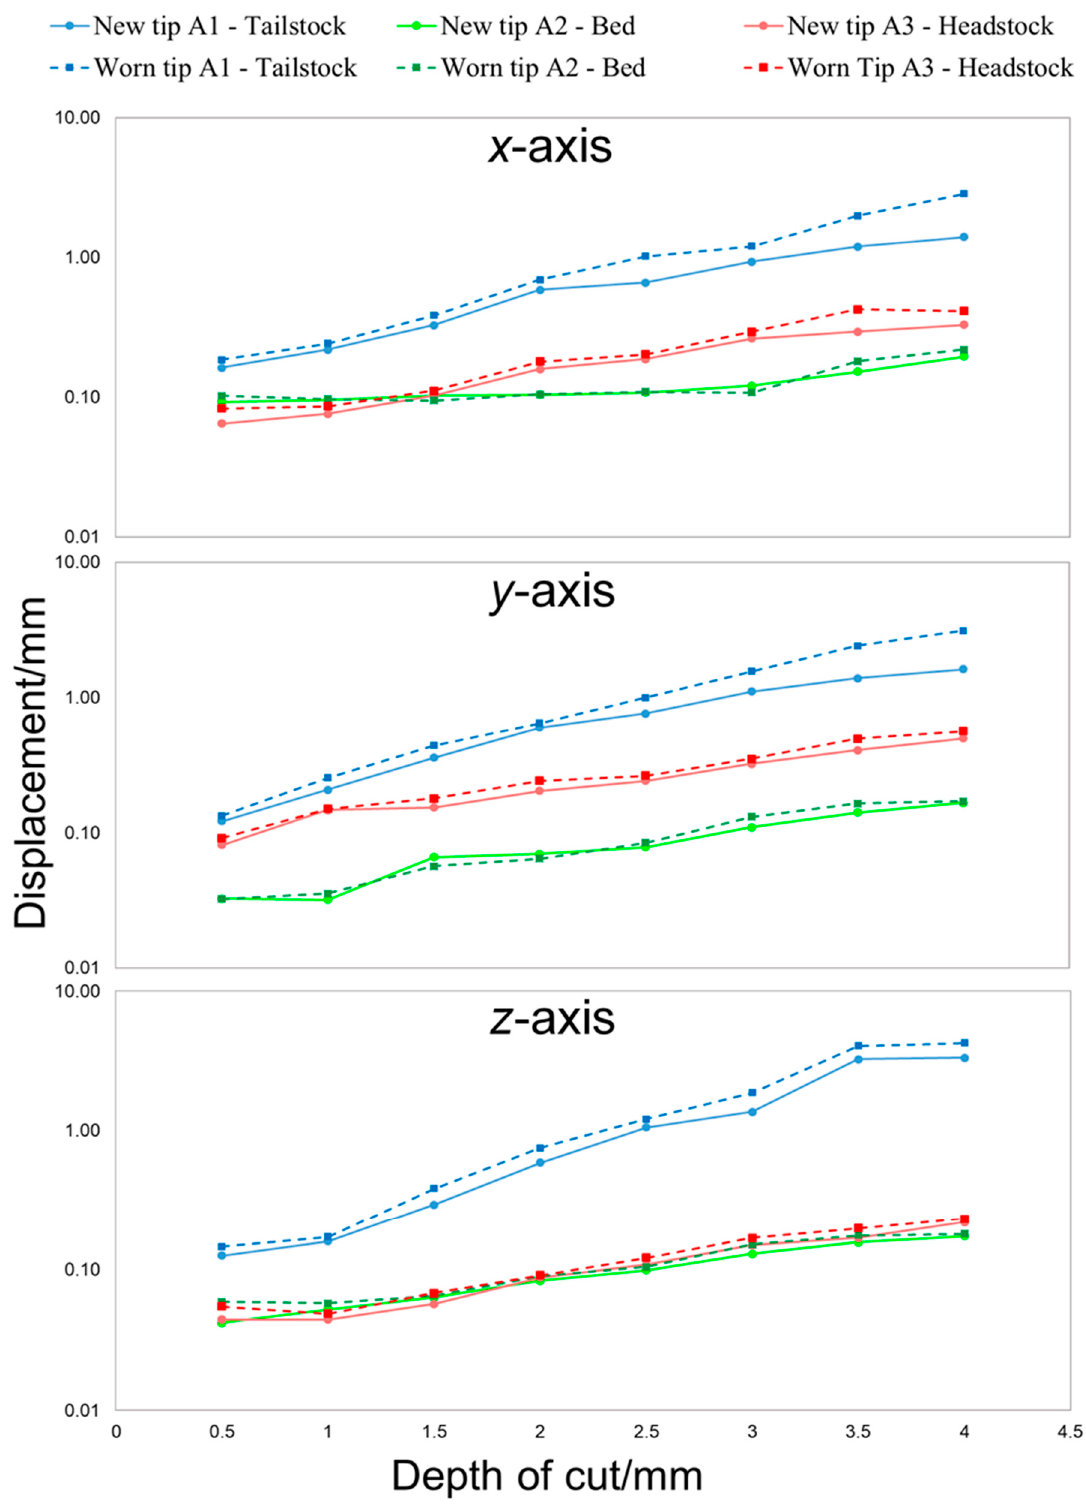
Figure 14. Vibration results in the x, y and z axes for the effect of increasing cutting depth and tool wear, showing the vibration increases that can be measured as the cutting tip progressively wears to predict tool failure.